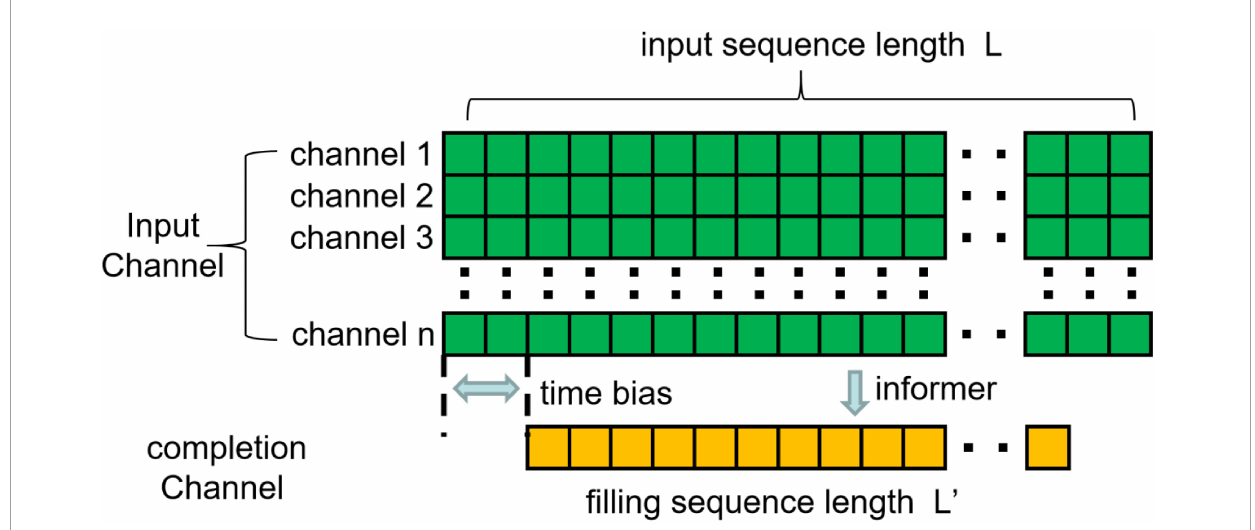
FIGURE3 Schematic diagram of the EC-informant structure. It includes two encoder layers and one decoder layer, and uses a self-attention distilling operation to effectively reduce the RAM usage requirements.